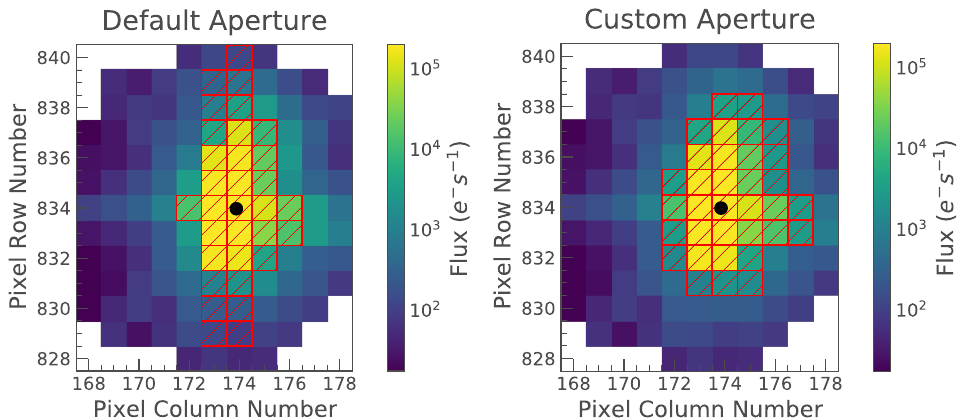
Figure 1. Pixel data of KIC 5080290 in Quarter 1. The left and right panels illustrate the default aperture used by the Kepler pipeline and the custom aperture adopted in this paper, respectively. Photometric apertures are highlighted with red slashes. The black point is the target star KIC 5080290. The color bar representing stellar flux is on the right side of each